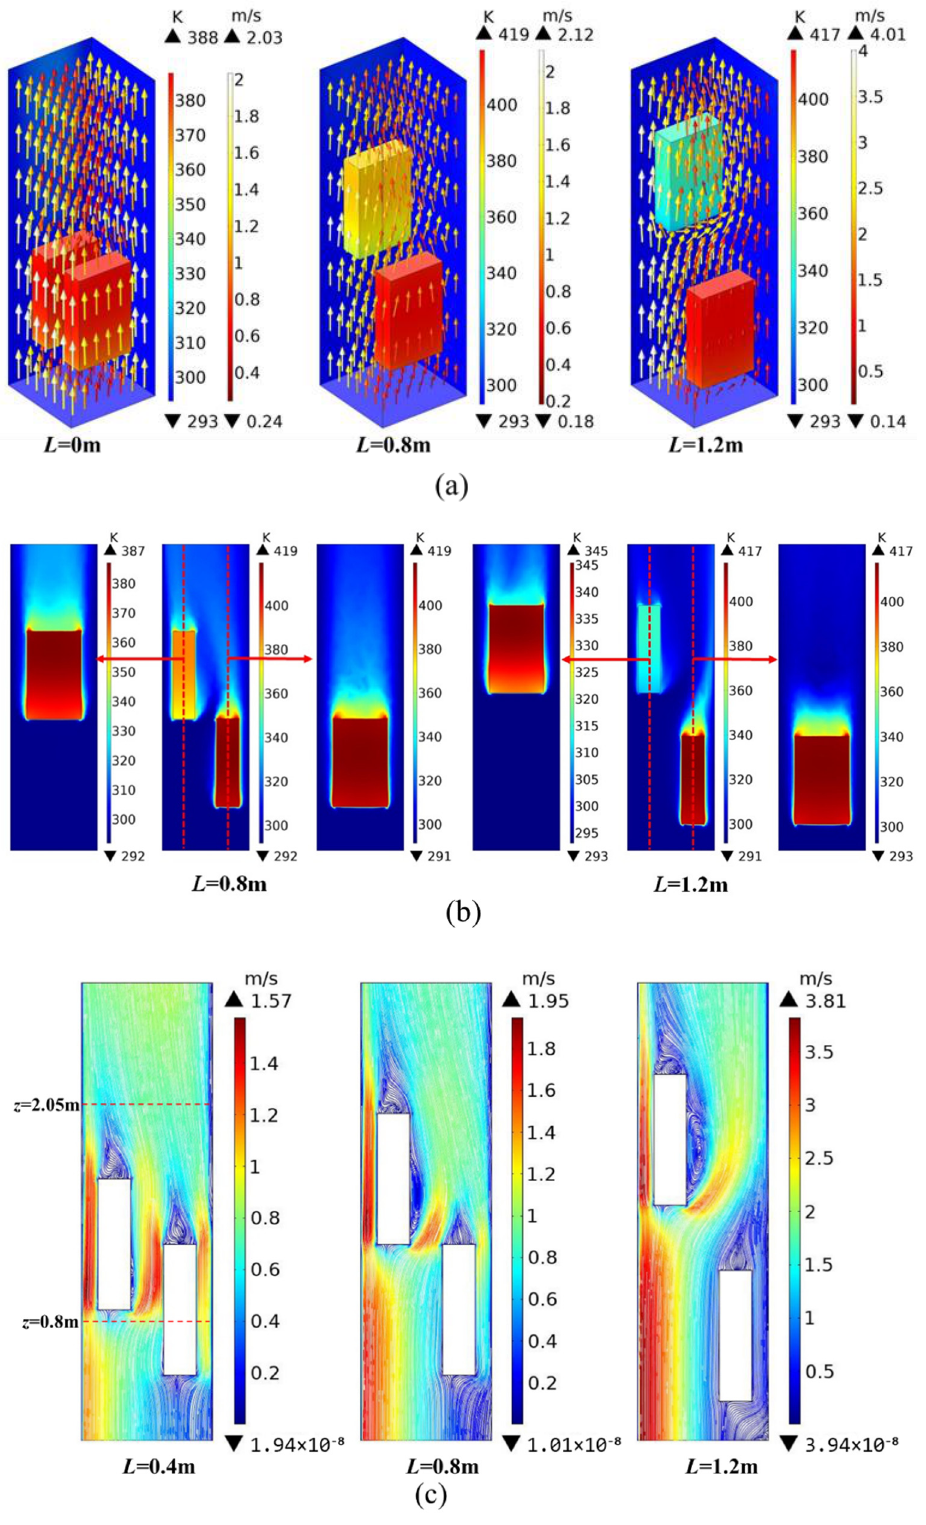
Figure 7. The temperature and velocity distributions in the channel with a different vertical altitude difference at X = 0.20 m. ( a ) The temperature and velocity vector distributions in the open-ended square channel. ( b ) The temperature distribution of the central cross section of the heat sources. ( c ) The velocity distribution in z direction at the cross section where y = W/2.